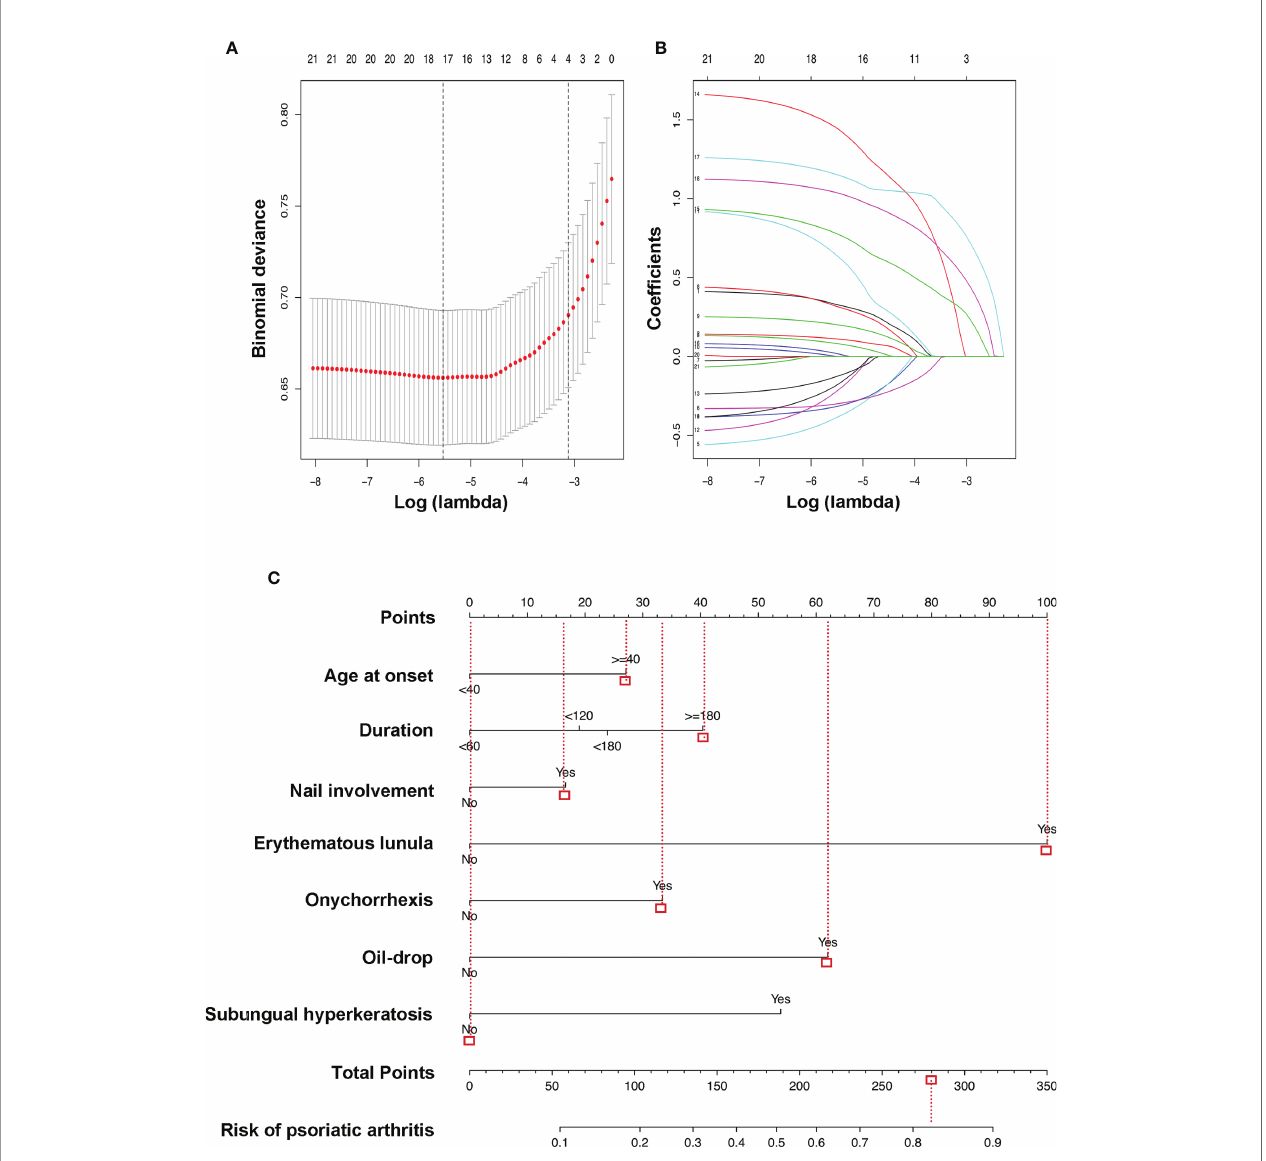
FIGURE 2 | LASSO binary logistic regression model and the risk of PsA predictive nomogram. Demographic and clinical feature selection using the LASSO binary logistic regression model. (A) In the LASSO model, optimal parameter (lambda) was selected by using a fi vefold cross-validation approach (20). Using the partial likelihood deviance (binomial deviance) curve and the log (lambda) plot, dotted vertical lines were drawn at the optimal values to obtain the included feature factors. (B) LASSO coef fi cient pro fi les of the 18 features. A coef fi cient pro fi le plot was generated based on the log (lambda) sequence. A vertical line was drawn at the values selected by using fi vefold cross-validation, where fi ve features with non-zero coef fi cients were selected. LASSO, least absolute shrinkage and selection operator; PsA, psoriatic arthritis. (C) The risk of PsA predictive nomogram was developed in the cohort, with age at onset, duration, nail involvement, erythematous lunula, onychorrhexis, oil drop, and subungual hyperkeratosis incorporated. Instructions: Draw a line straight upward to the point ’ s axis to determine how many points the plaque psoriasis patient receives for the risk of psoriatic arthritis (e.g., a plaque psoriasis patient with nail involvement will receive between 10 and 20 scores). Repeat the process for each variable. Total the points achieved for each of the predictors. Locate the fi nal sum on the Total Points axis. Draw a line straight down to fi nd the plaque psoriasis patient ’ s probability of having psoriatic arthritis. For example, a male plaque psoriasis patient was 50 years old and had a history of plaque psoriasis for 5 years. The age at onset was approximately 45 years. He has nail involvement, including pitting, erythematous lunula, onychorrhexis, and oil drop, without leukonychia, onycholysis, subungual hyperkeratosis, or splinter hemorrhages. According to the predictive equation, the plaque patient ’ s probability of having psoriatic arthritis was